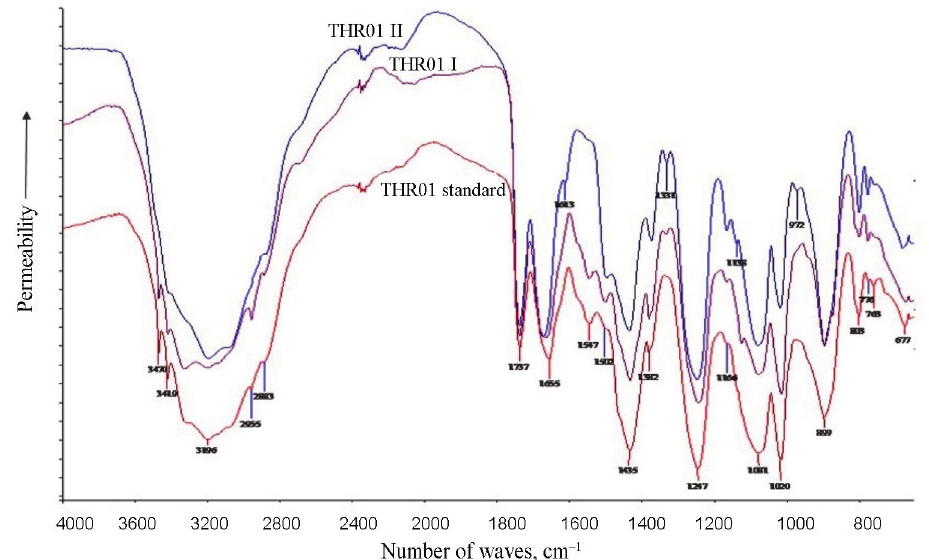
Figure 8. Intumescent fire protective coating THR01 samples of FT-IR spectra: THR01 standard – control samples, THR01 I – the coating was aged by I regime, THR01 II – aged by II